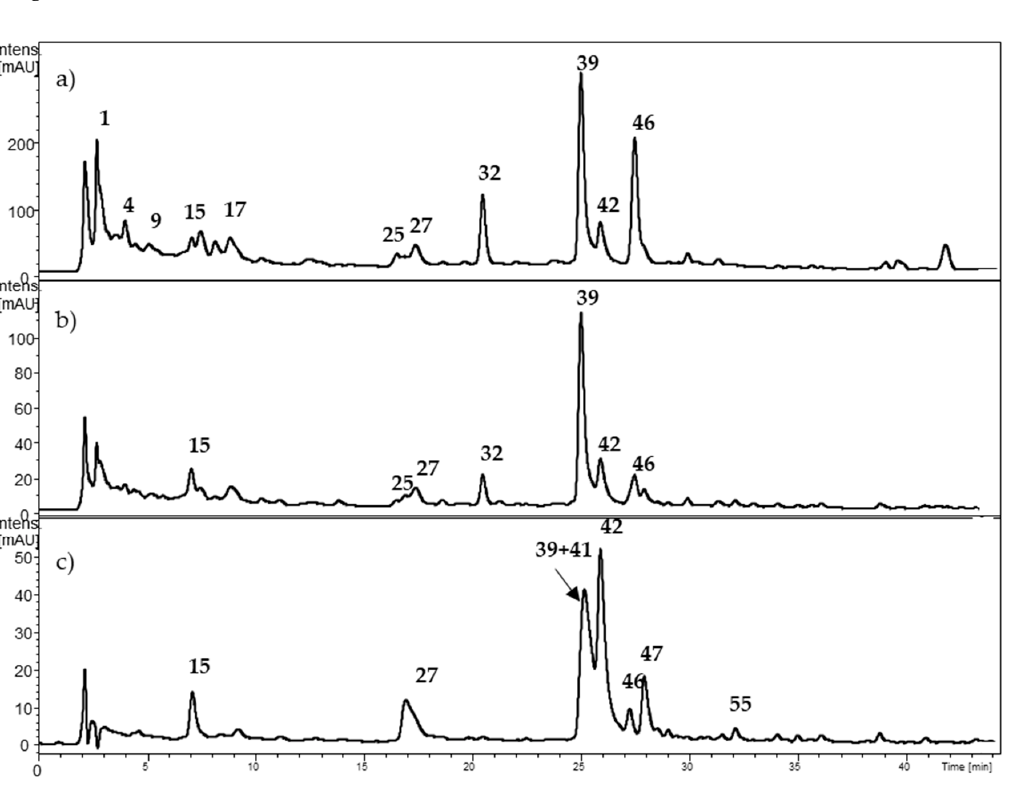
Figure 5. HPLC-DAD chromatogram from Fragaria chiloensis at ( a ) 280 nm; ( b ) 320 nm; and ( c ) 360 nm. The numbers correspond to Table 3.